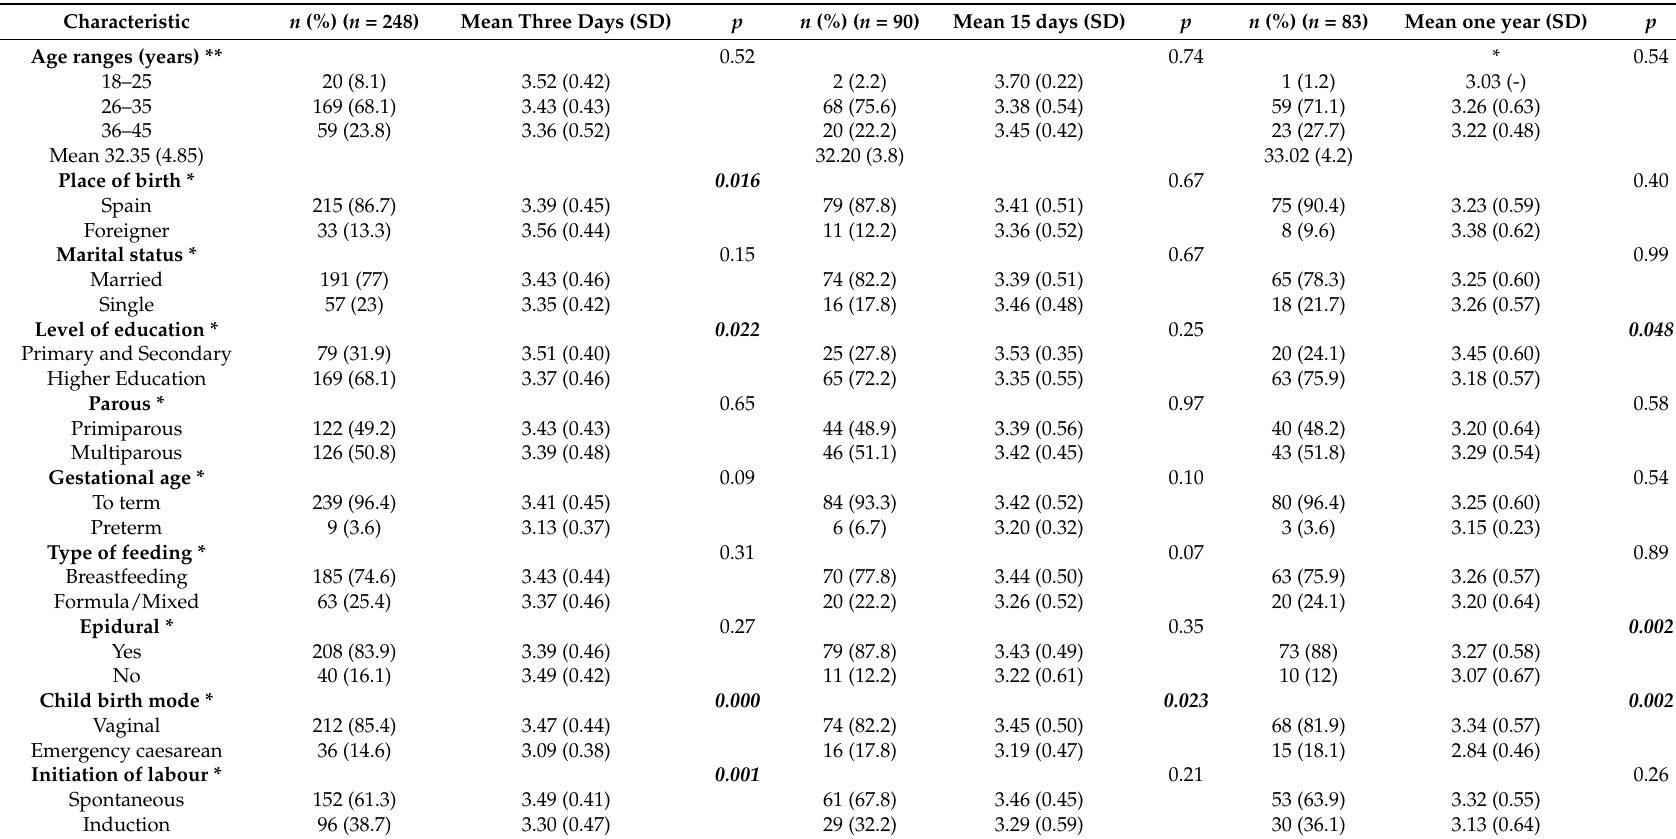
Table 1. Socio-demographic characteristics ( n and %), mean scores in the Intrapartal-Specific Quality from the Patient’s Perspective Questionnaire (QPP-I)scale, and statistical associations at each time point when the questionnaire was